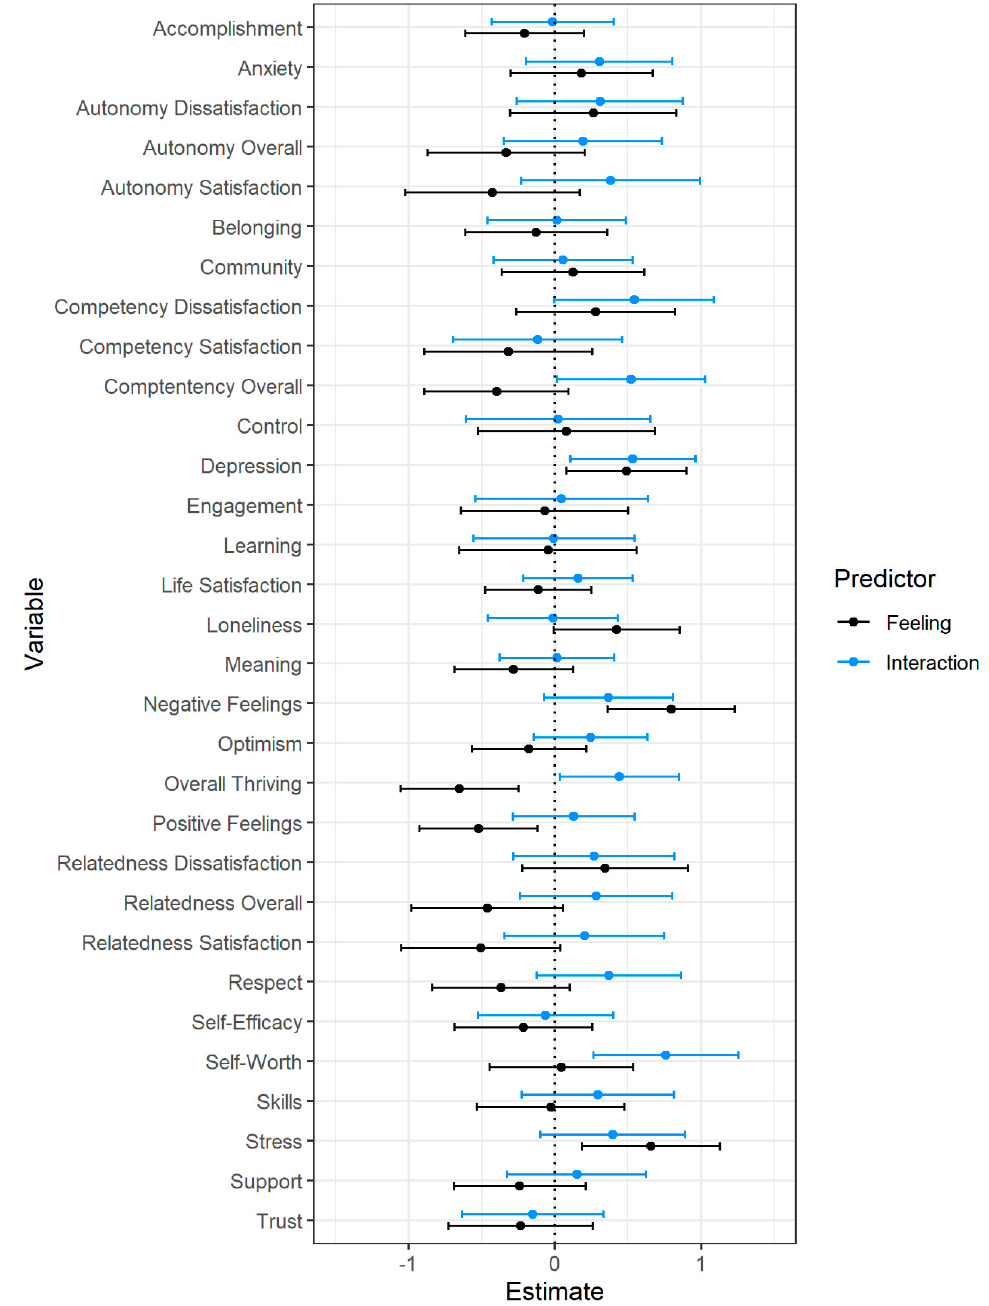
Figure 6. Latent feeling topic factor and interaction predicting post-intervention well-being. Note. Estimates represent regression weights (controlling for pre-intervention well-being) in pre-intervention standard deviation units. Error bars represent 95% confidence intervals.